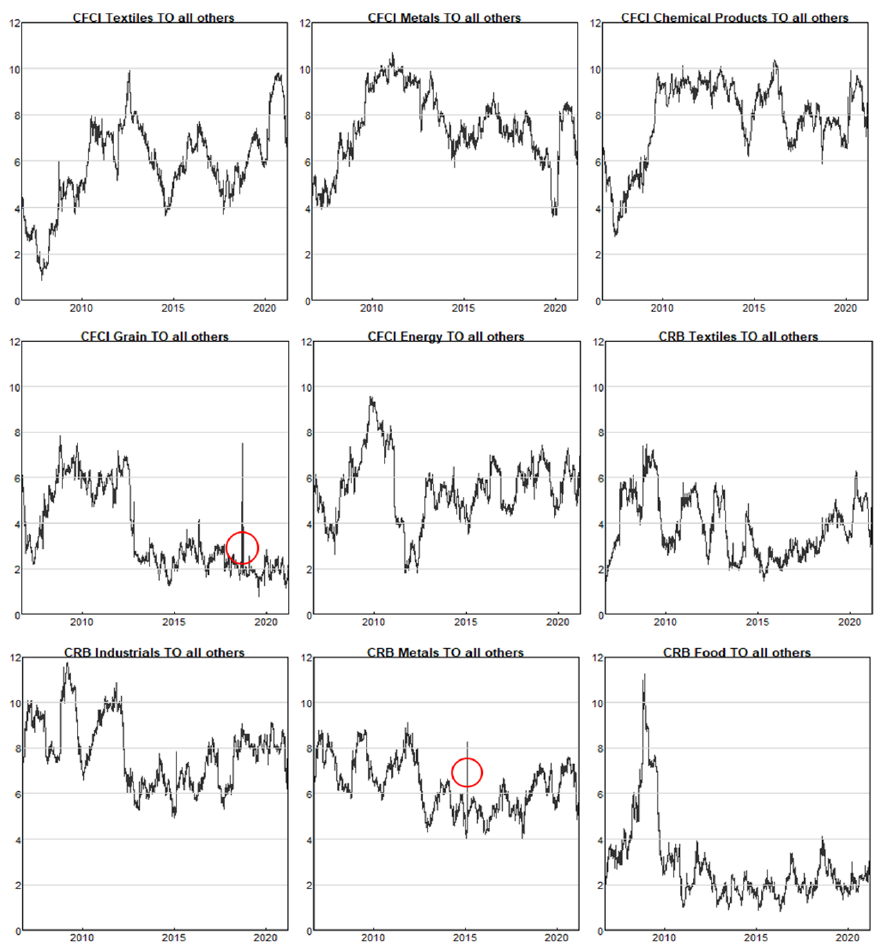
Figure 2. The “OUT” total directional volatility spillover of the rolling sample.